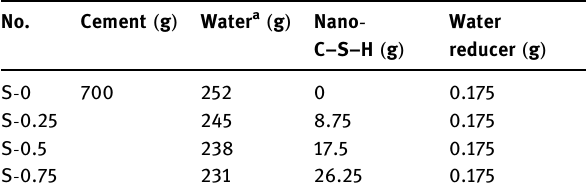
Table 2: Mix proportions of cement paste No.